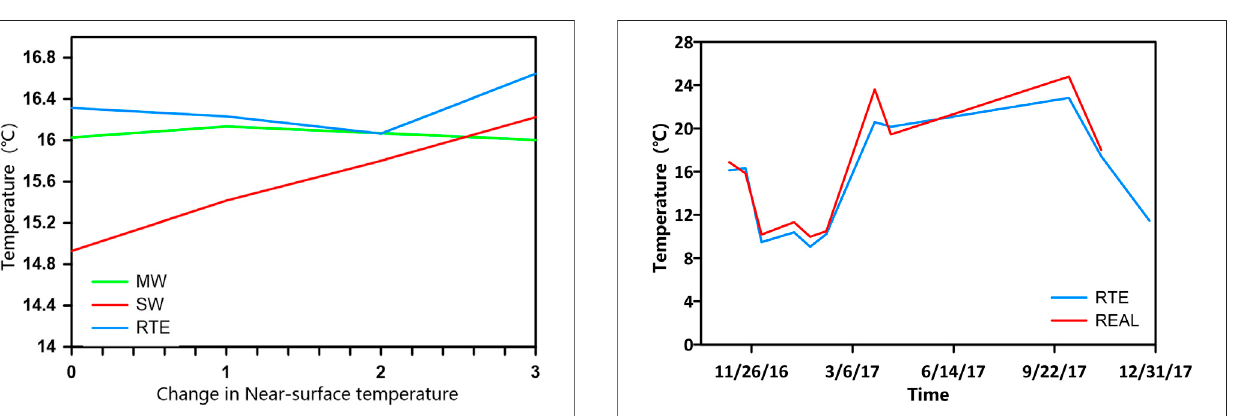
FIGURE 6 | Variation of surface temperature due to near-surface temperature error.